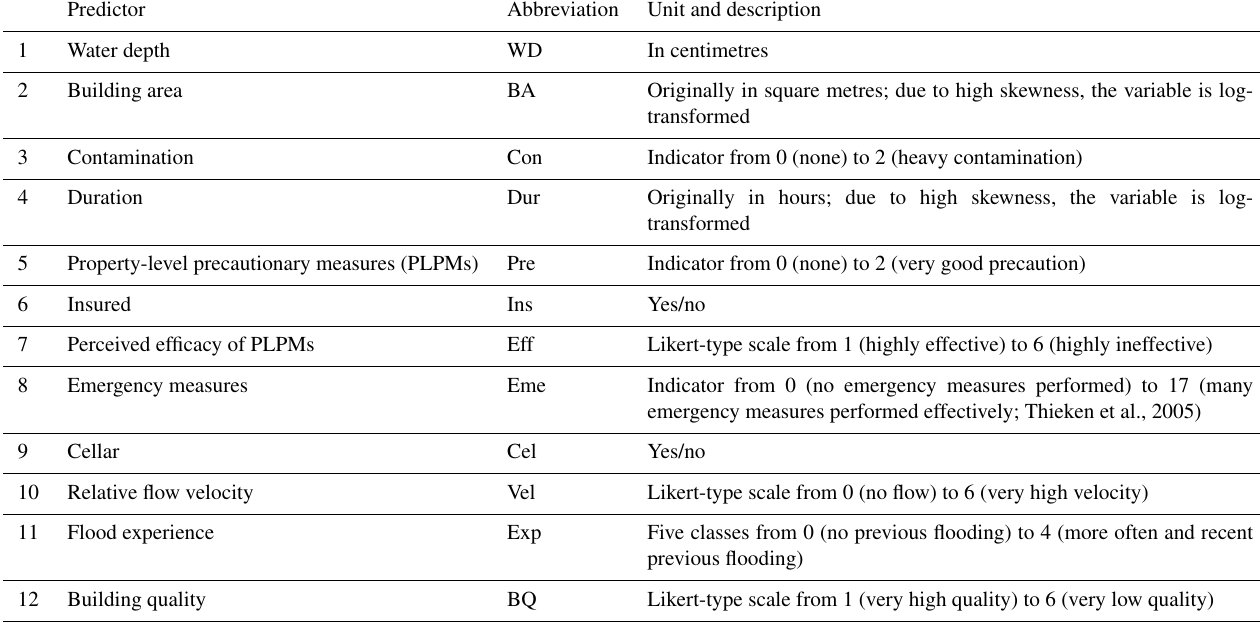
Table 1. Description of potential predictors of flood loss.